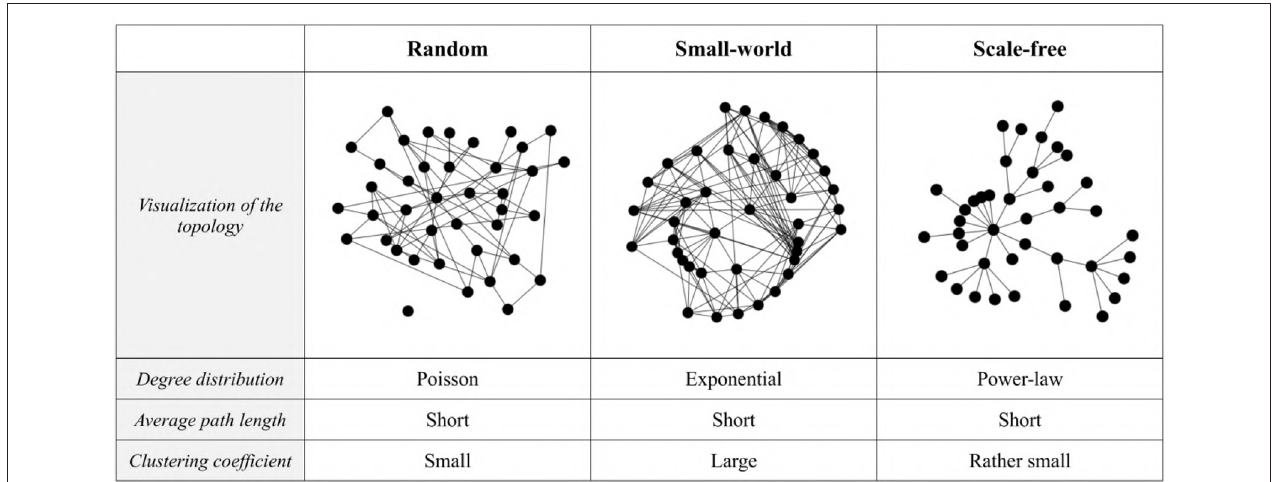
FIGURE 2 | Examples of random, small-world, and scale-free networks with N = 40 nodes. The degree distribution is the probability distribution of the nodes’ degree (the number of connections each node has to other nodes) over the whole network. The average path length is the average number of steps along the shortest paths for all possible pairs of network nodes. The clustering coefficient corresponds to the density of neighborhood, i.e., the degree to which nodes in a graph tend to cluster together ( Watts and Strogatz,